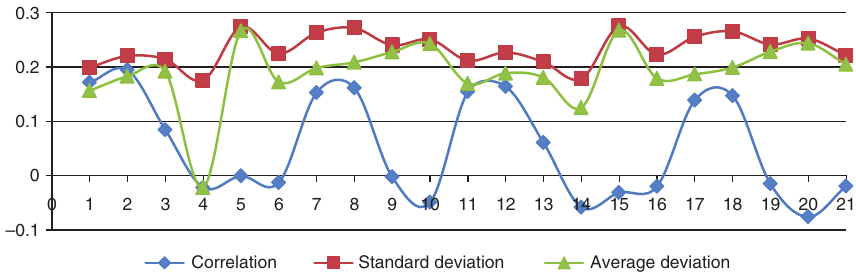
Figure 15: Results for Kaggle Brief Question Answer Evaluation Data Set for Score Class (2–3).